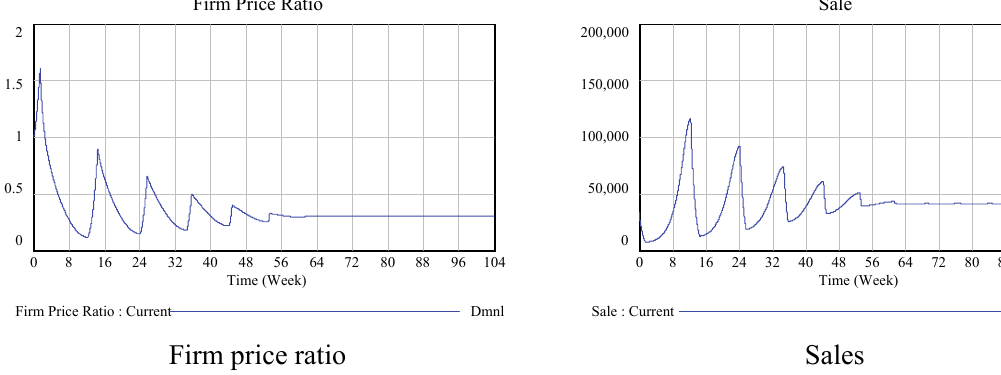
Fig. 8. The trend on price and sales figures